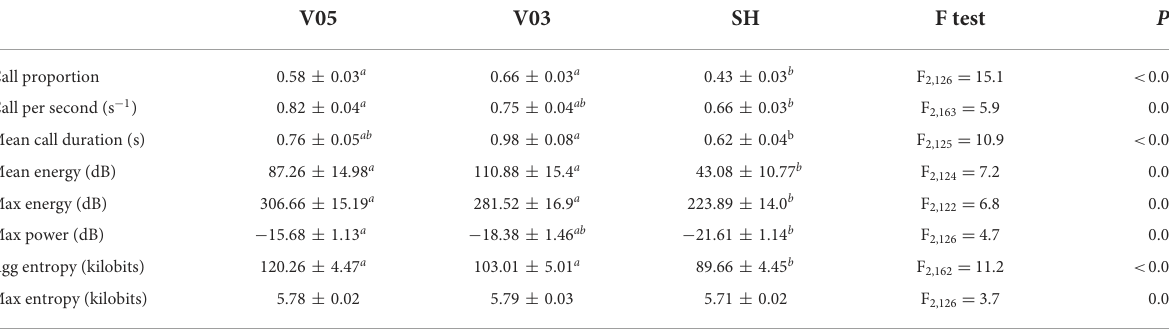
TABLE 4 Averages ( ± SE) of vocal parameters recorded during injection of the local